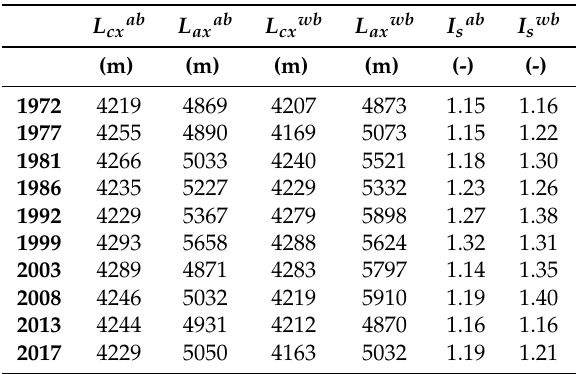
Table 9. Cartesian ( · cx ) and axial ( · ax ) lengths ( L ), sinuosity index ( I ) of active ( · ab ) and wet ( · wb ) channels, extracted from the elaboration of the Seman River LANDSAT imagery, time period 1972–2017.